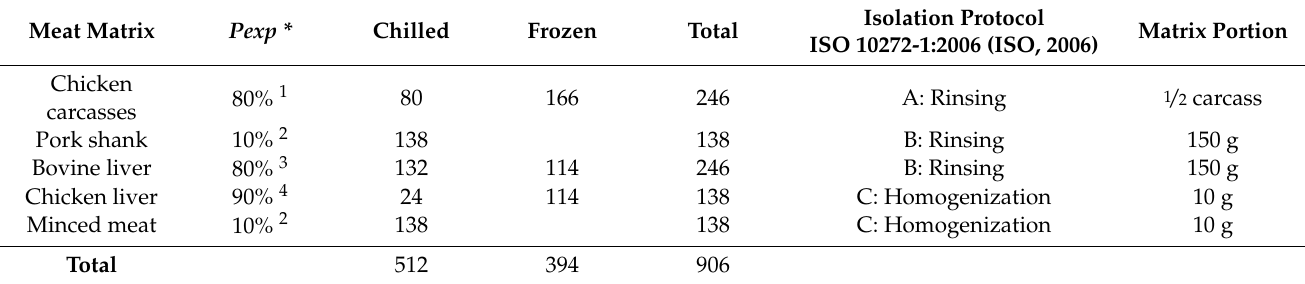
Table 1. Number, sample types and sampling methods used in the study.